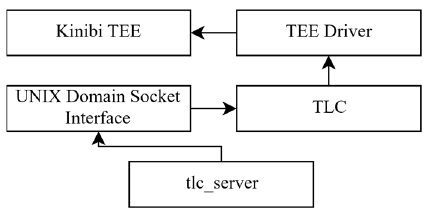
Figure 10. Kinibi TEE communication scheme.